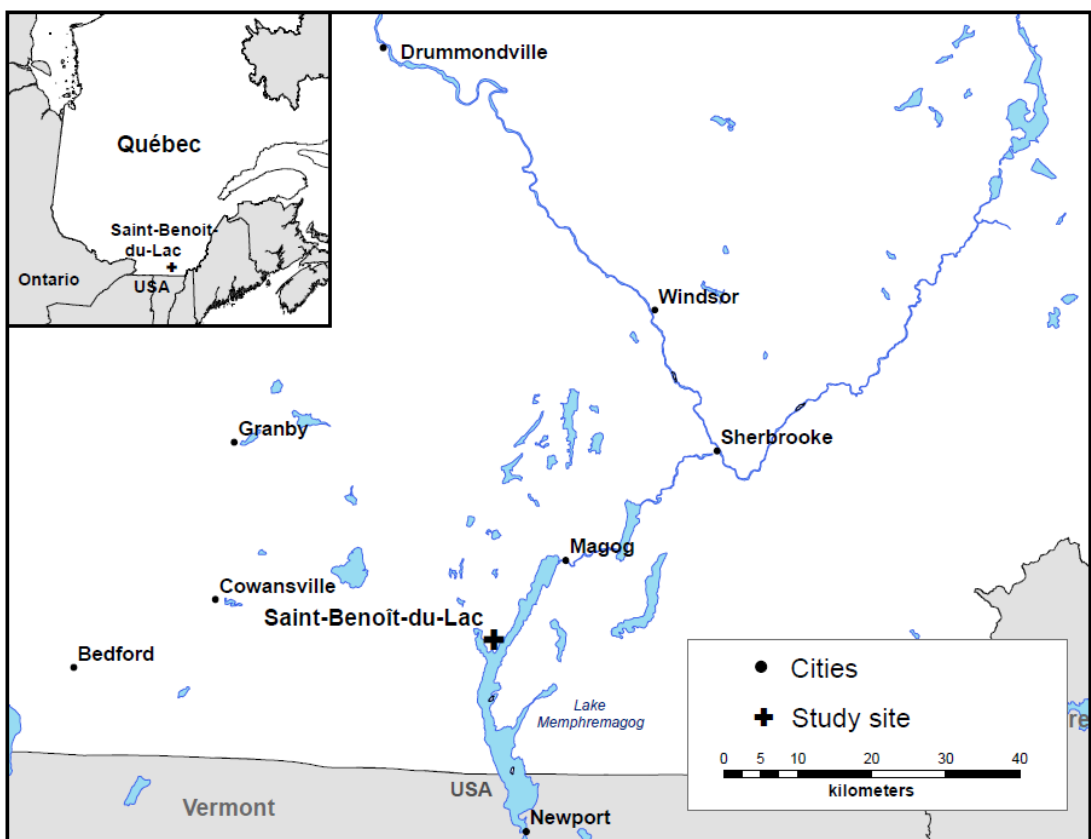
Figure 1. Study site location in the southern Québec region,